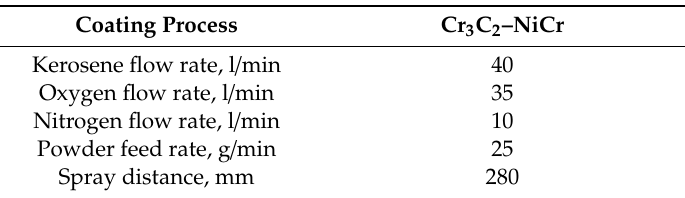
Table 1. Process parameters of HVOF